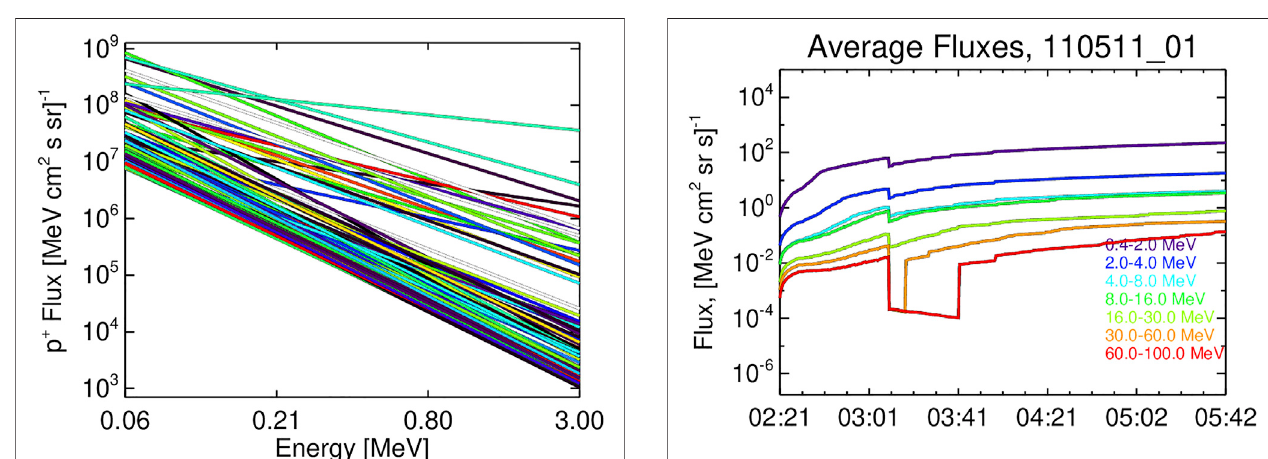
FIGURE 8 | Differential proton fl uxes simulated with the DSA model for the event, aggregated in 7 energy channels between 0.4 and 100 MeV. The sharp drop in the fl uxes is due to the sudden change of the geometric model between a spheroid and a partial spheroid around 03:10.